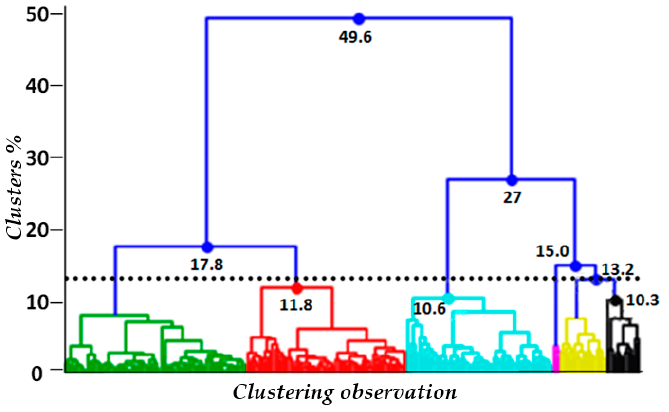
Figure 9. Dendrogram for time series